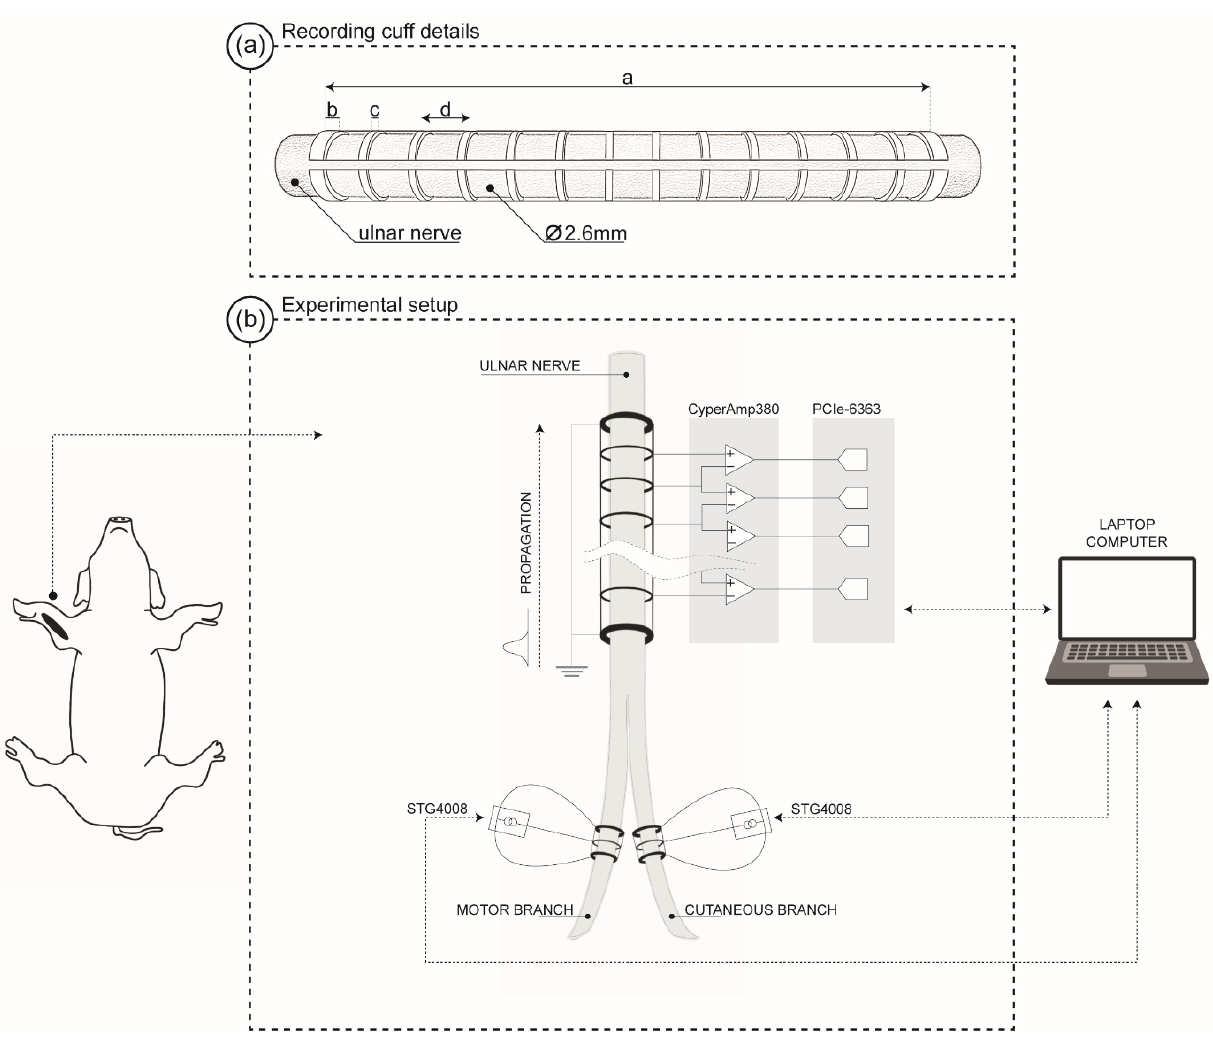
Figure 1. ( a ) Diagram of the 14 rings multi-electrode cuff (MEC). The length of the MEC (a) was 50 mm, with end-rings (b) of 1 mm width, the centre electrodes (c) had a width of 0.5 mm, and the inter-electrode distance (d) was 3.5 mm. The approximate diameter of the cuff was 2.6 mm. ( b ) Experimental setup for recording the neural responses evoked by ulnar nerve electrical stimulation. Tripolar cuffs were used for the stimulation, whereas a multi-electrode cuff was used to record the electroneurogram (ENG)